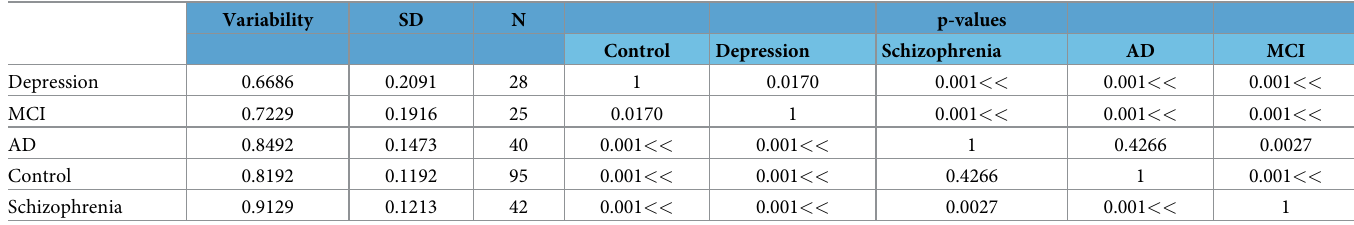
Table 4. Cross correlation analysis between participant’s electrodes–local.